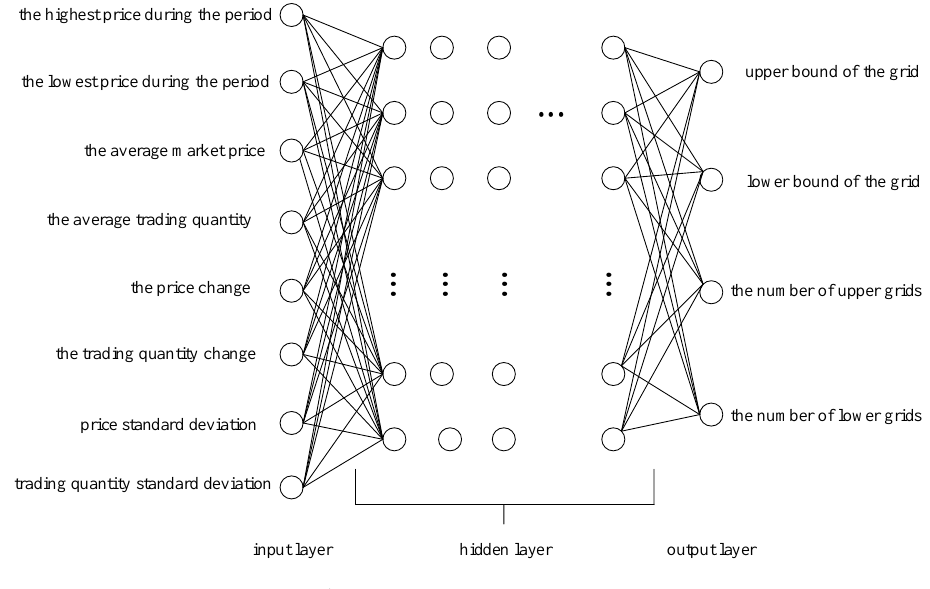
Figure 7. ANN architecture.